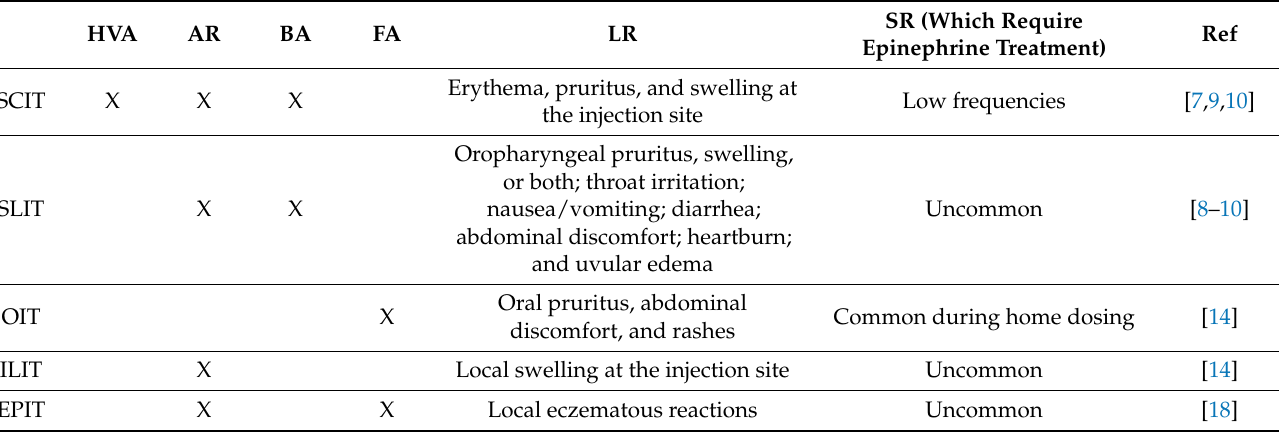
Table 1. Types of immunotherapy and their application in allergic